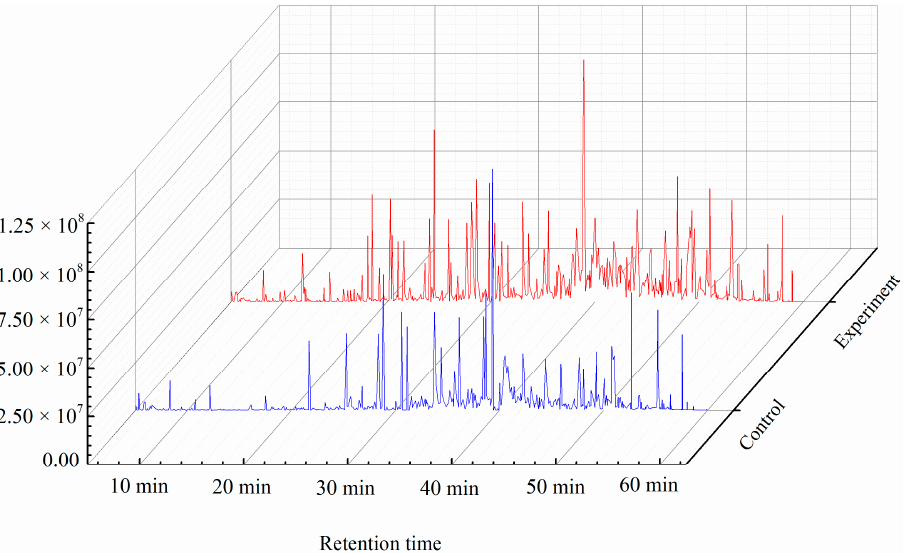
Figure 5. Comparison of gas chromatography–mass spectroscopy total ion diagram of in situ regulated and nonregulated smoking samples. The types and contents of PPs during the smoking process remarkably changed after the regulation. Thirteen PPs were detected in the experimental group (Table 3). Aside from the eleven PPs in the control group (Table 1), (12) homoprotocatechuic acid and (13) catechin were also detected. These PPs were detected only on the first day of the smoking process. The distribution of PPs at the end of the smoking process after the regulation was analyzed. Similar to the control group, the number of PPs detected at the end of the smok- ing process in the experimental group was also nine. However, PP 8 disappeared in the experimental group and PP 10 was detected instead. As the main PPs in the control group, the content of PPs 1, 2, 3, 6, and 9 in the experimental group accounted for 6.77%, 14.04%, 37.26%, 23.12%, and 7.34%, respectively, for a total of 88.53% of the total amount of PPs. Therefore, PPs 1, 2, 3, 6, and 9 were also the main compounds in the experimental group. Similarly, PP 3 had the highest proportion, thus it was also the most important PP in the experimental group. Compared with that in the control group, the content of seven PPs, namely, PPs 1, 2, 3, 4, 5, 6, and 10, in the experimental group increased. Among them, the PPs with larger increments were PPs 3, 4, and 10, and their increments accounted for 81.90% of the TWSP increments. Therefore, the regulation strategy mainly promotes the production of PPs 2, 3, 4, and 10 to increase the accumulation of TWSP.